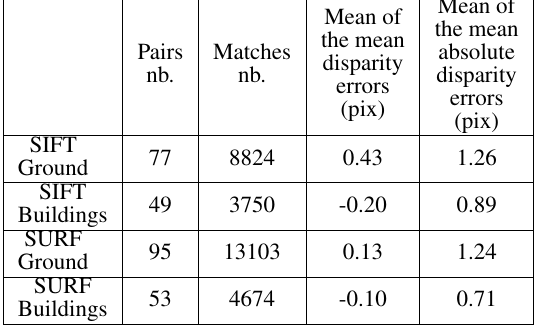
Table 2. Disparity errors (in pixels), computed using SIFT or SURF matches, over stereo-rectified images pairs and disparity maps, extracted from the 122 pairs of Tab. 1, with the 33 matches minimum threshold per class and per keypoints type.